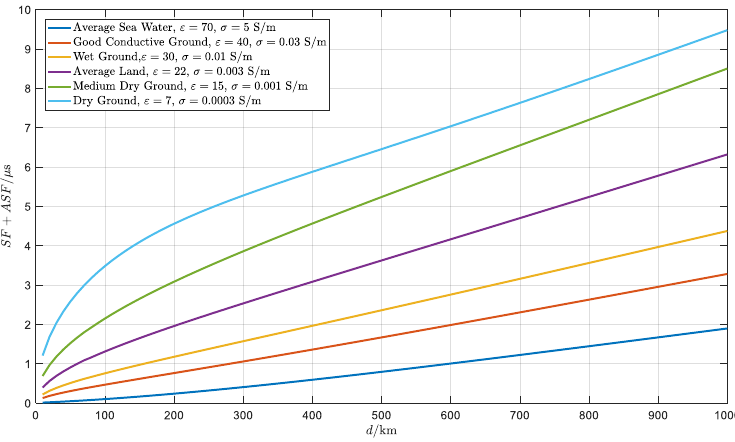
Figure 1. The trend of SF + ASF via distance.